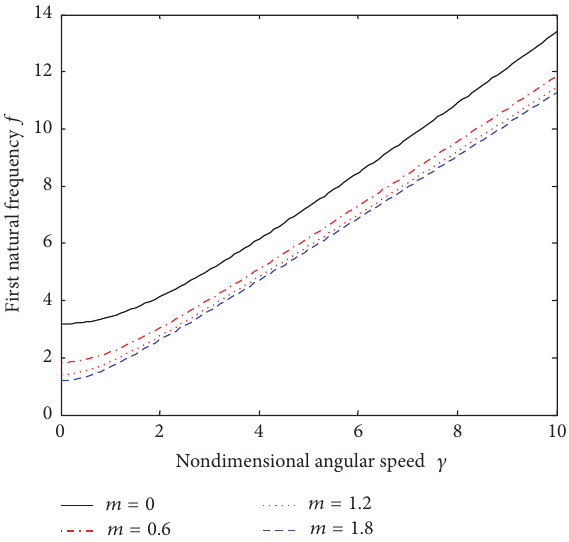
Figure 2: Effect of the concentrated mass on the first natural frequency.